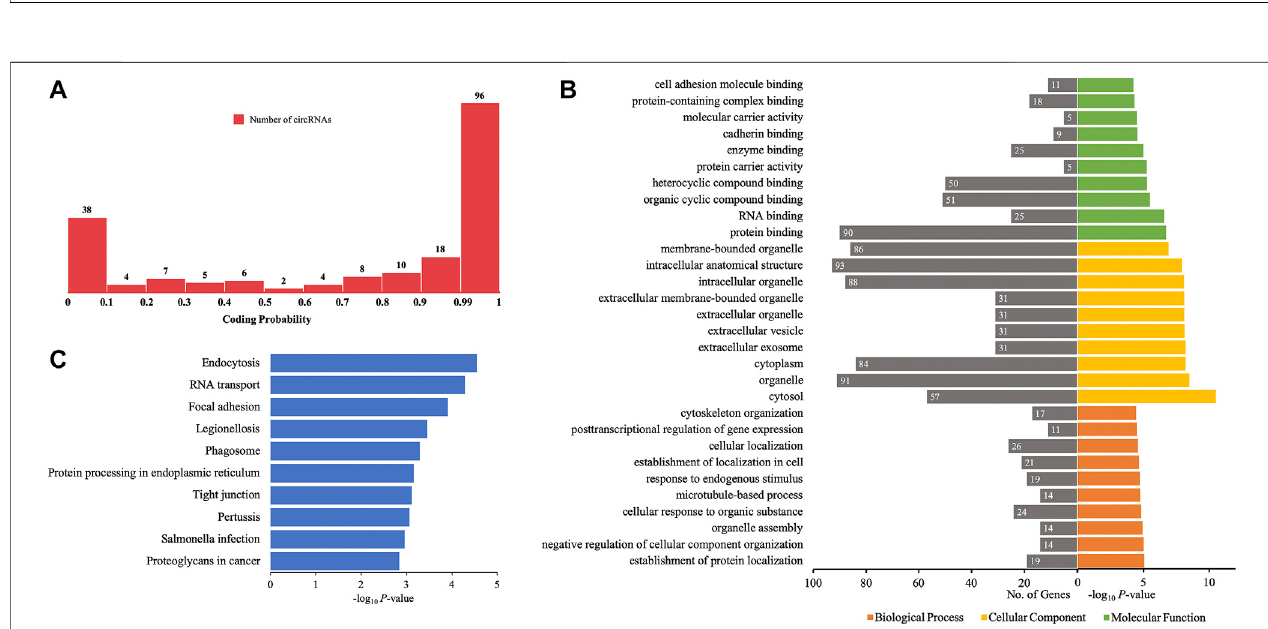
FIGURE 7 | GO annotations and KEGG pathway analyses for proteins potentially coded by differentially quanti fi ed circRNAs. (A) Distribution of the coding probability of differentially quanti fi ed circRNAs. (B) GO annotations. The GO analysis categorized the genes into different groups under the theme of biological process, cellular component, and molecular function. The gene count for each GO category is listed on the left. (C) Top 10 KEGG pathways. The vertical axis indicates the pathway category, and the horizontal axis indicates the − log 10 p -value of a pathway (Fisher ’ s exact test).